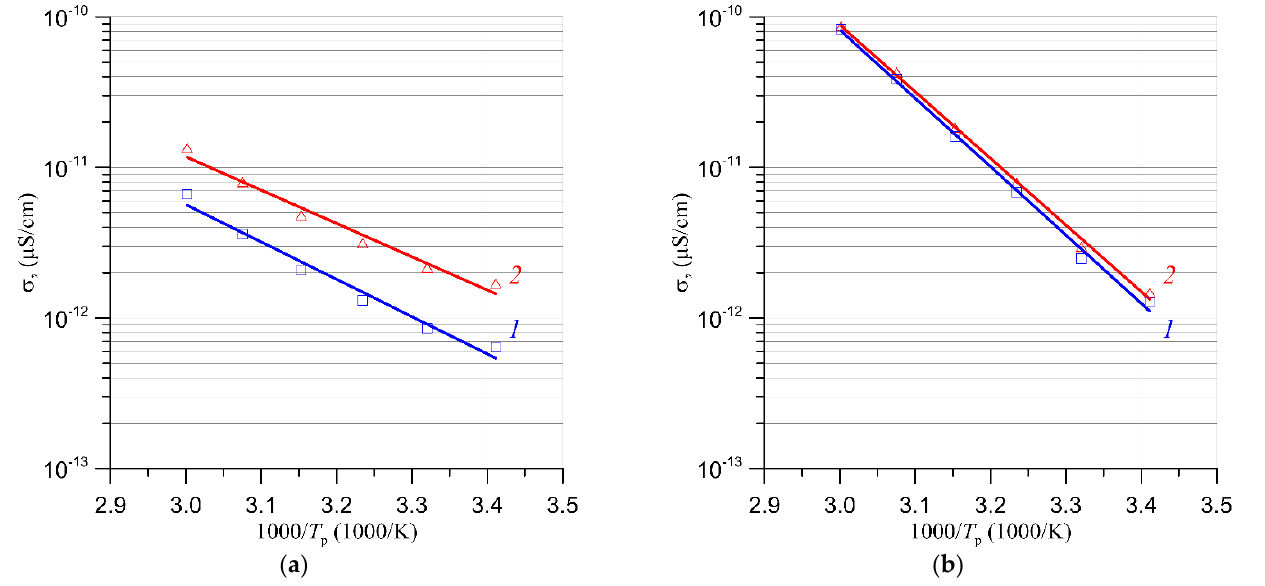
Figure 7. AC conductivity Arrhenius plots of mineral ‐ insulating oil with a moisture content of 5 ppm—( a ) and moistened mineral oil—( b ) at temperatures from 293.15 K to 333.15 K in steps of 8 K for measuring frequencies of 10 − 4 Hz (1) and 1 Hz (2).